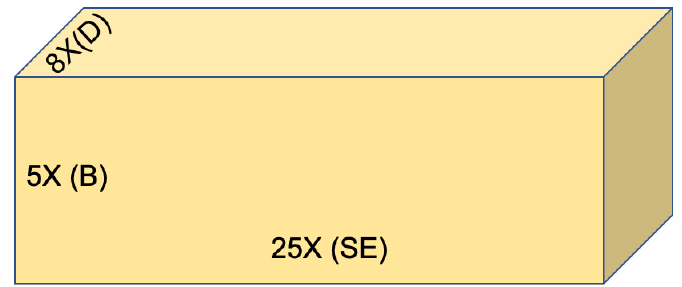
Figure 1. Rectangular container with coordinates of D , B , and SE